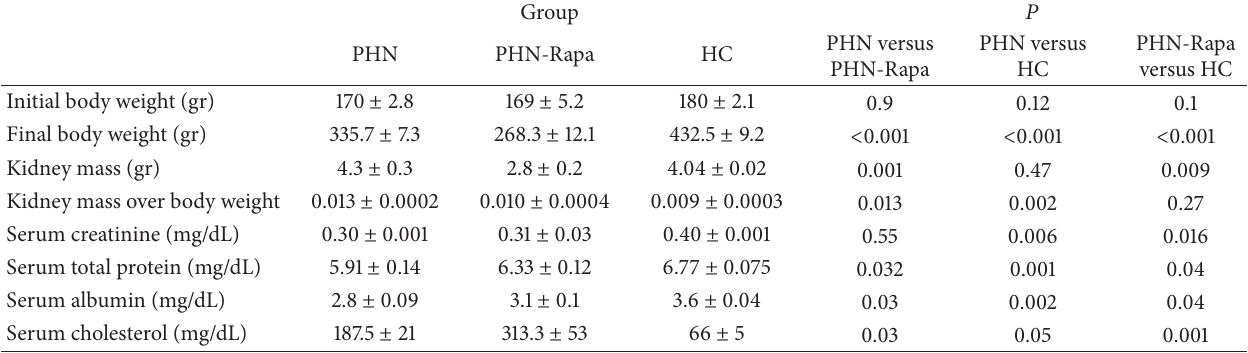
Table 1: Clinical and biochemical characteristics of groups under study.